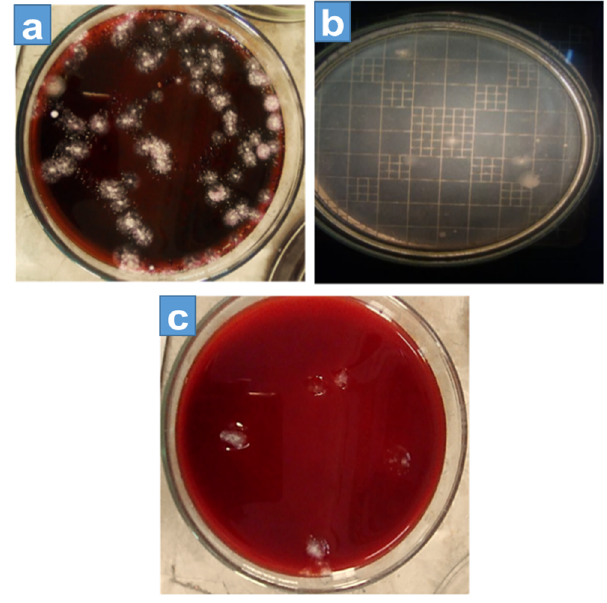
Figure 4. Colony-forming unit count on ( a ) MacConkey agar ( b ) nutrient agar, and ( c ) EMB agar. Table 2. Viable counts of the colonies on eosin methylene blue agar, nutrient agar, and on Mac- Conkey agar.